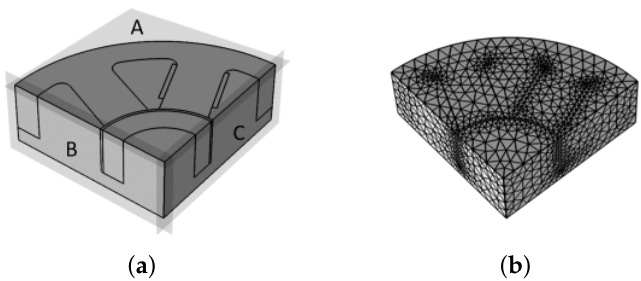
Figure 5. 3D finite element model showing the planes used to reduce the size of the numerical model ( a ); meshed geometry of the system based on the semi-hard magnetic material ( b